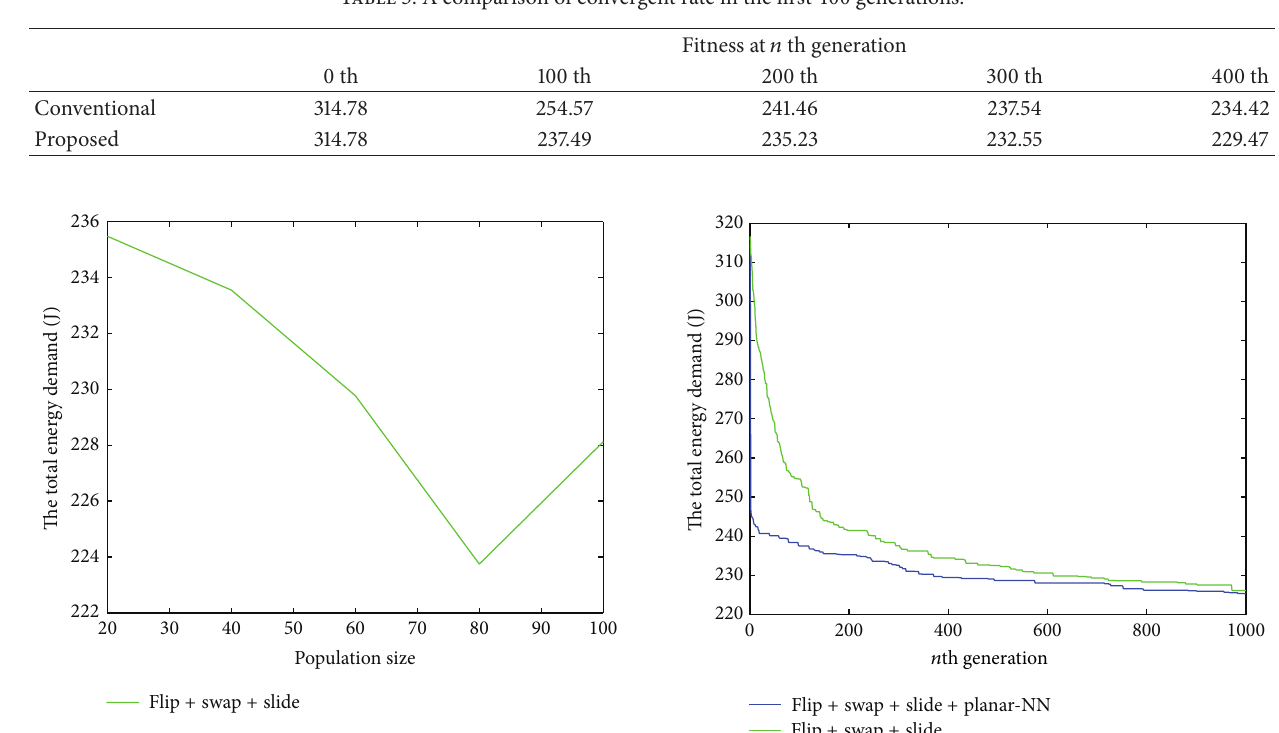
Table 5: A comparison of convergent rate in the first 400 generations.